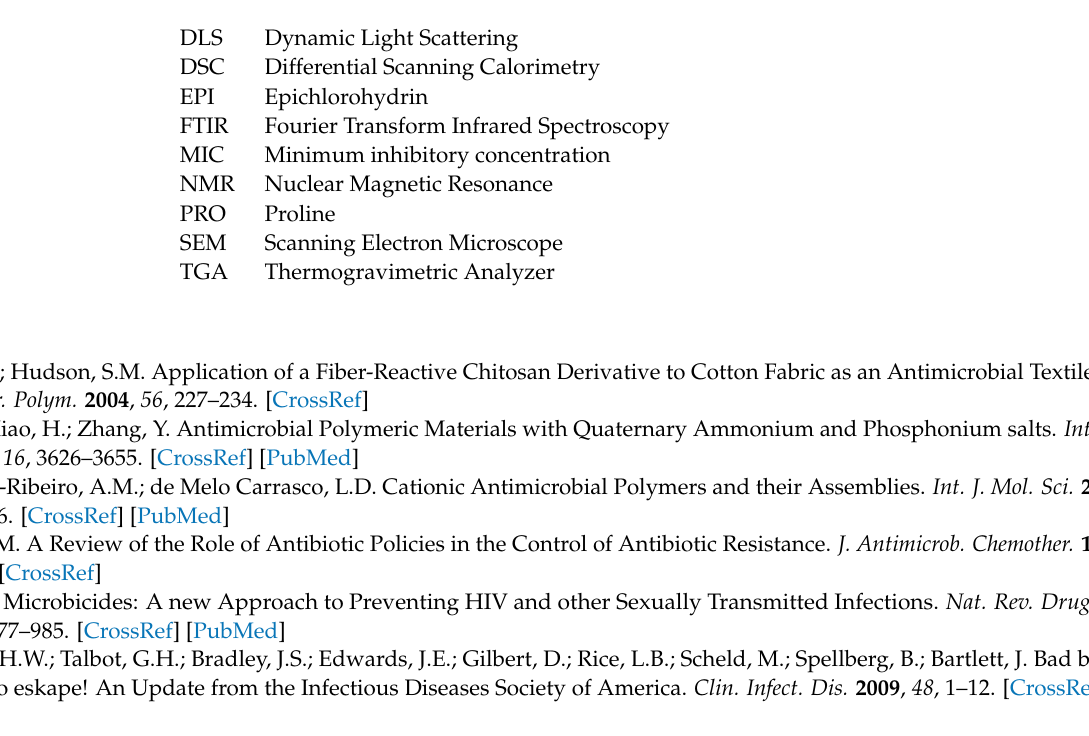
Figure S2: Sample microtiter plate showing the MICs for tested compounds against Gram-negative microorganism on E. coli , P. aeruginosa and S. aureus . Note: Top to bottom concentrations are 256, 128, 64, 32, 16,8, 4, and 2 ug/ml. Top left: E. coli ; Top right: Pseudomonas ; Bottom: Staphylococcus . Blue color represents inhibition and pink color represents growth.; Figure S3: UV–vis spectra absorption spectra kinetic plots of ln A (A = absorbance at 498 nm) versus